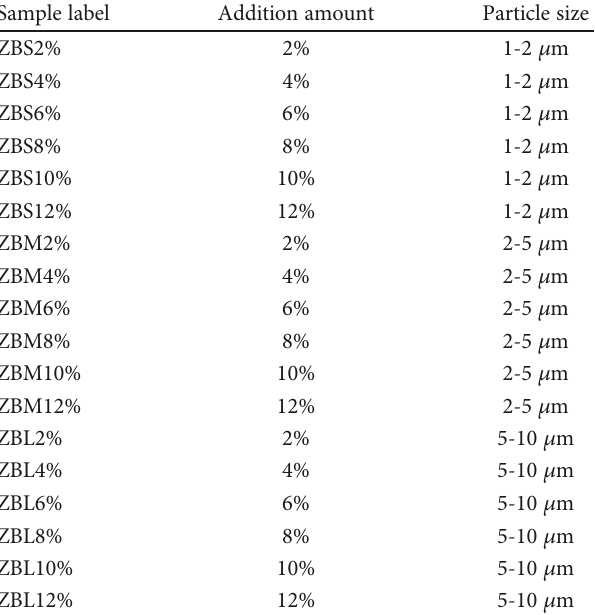
Table 1: Interpretation of sample